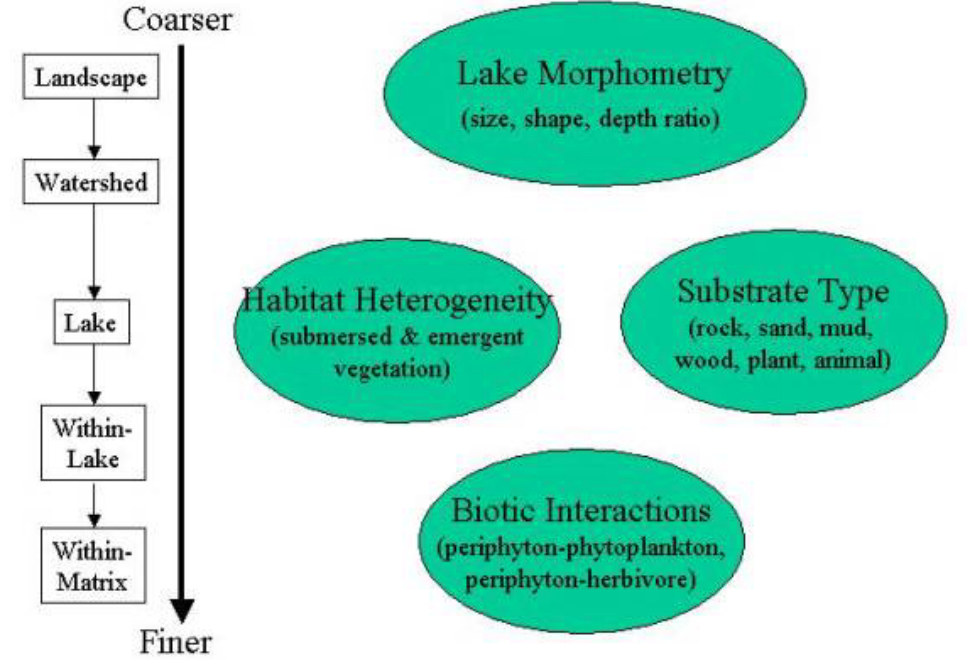
FIGURE 1. Hierarchical arrangement of possible factors influencing periphyton function in lake ecosystems, ordered from the coarsest level (top) to finest level (bottom). See text for additional